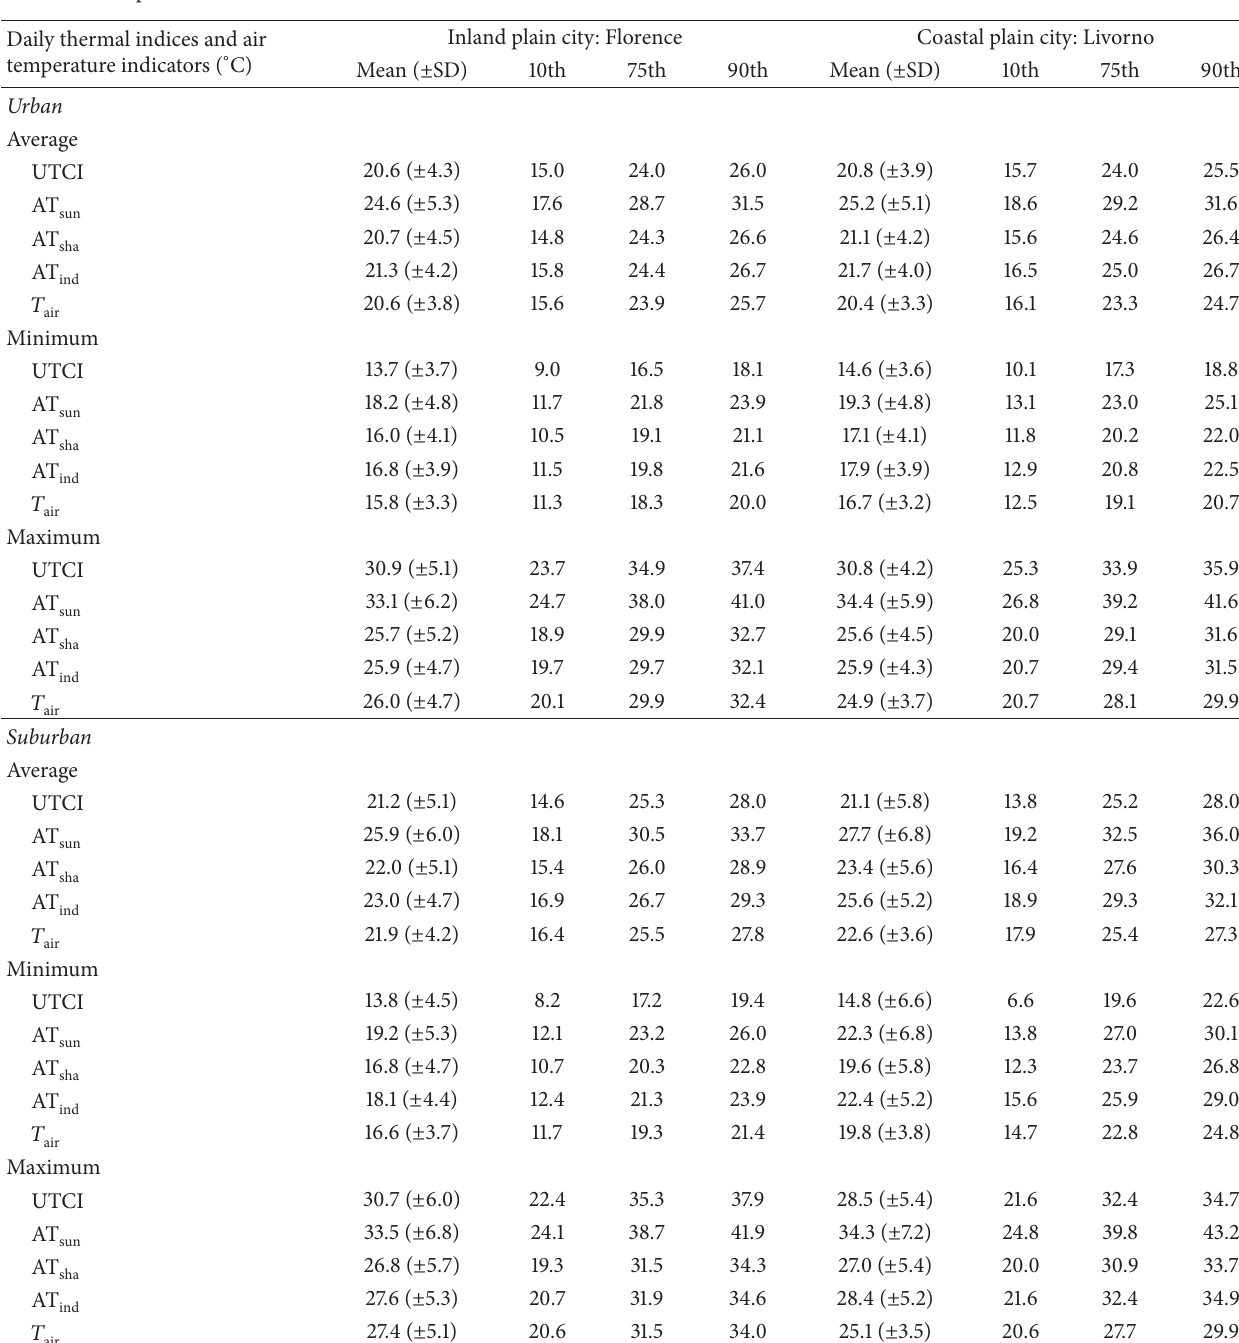
Table 2: Descriptive statistics of daily thermal indices and air temperature indicators assessed and measured in urban and suburban areas of Florence and Livorno during the warmest period of the year (May–October) from 2006 to 2008. Mean, standard deviation (SD), and 10th, 75th, and 90th percentiles are